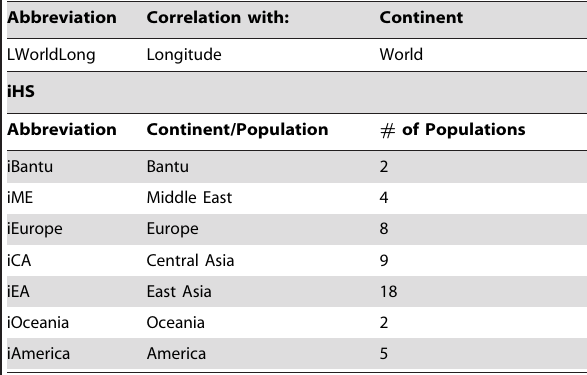
*Correlation was calculated between allele frequency and the absolute value of the